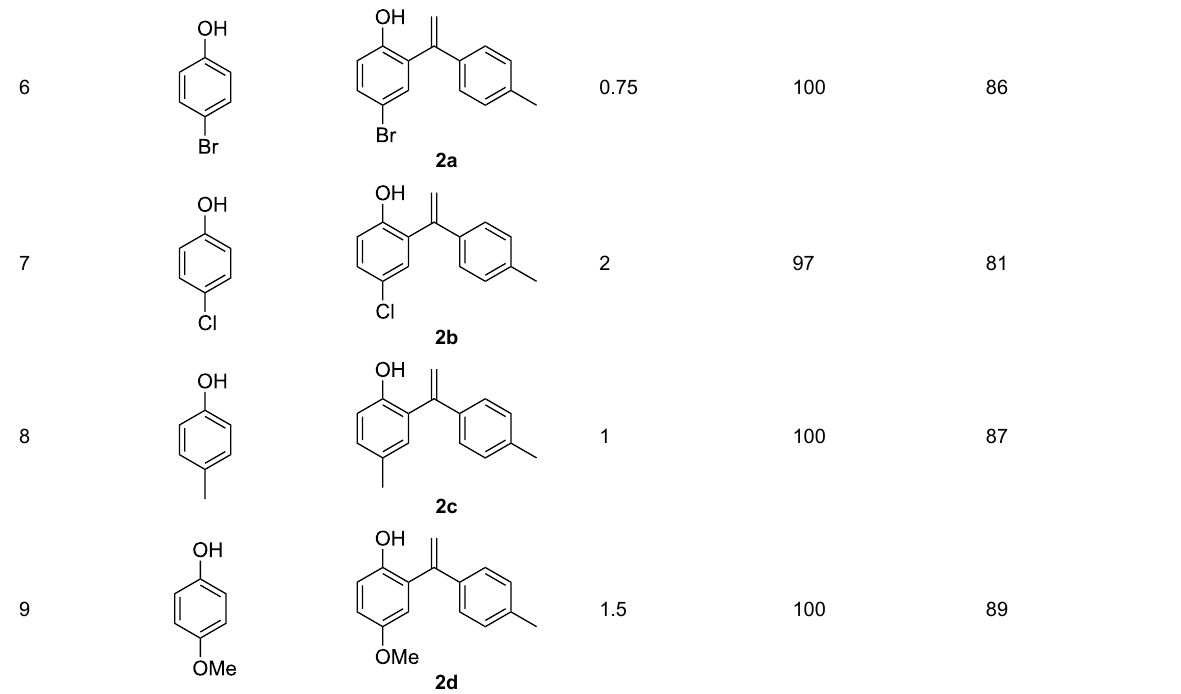
Table 3: Reactions of arenes with phenylalkynes a . (continued)